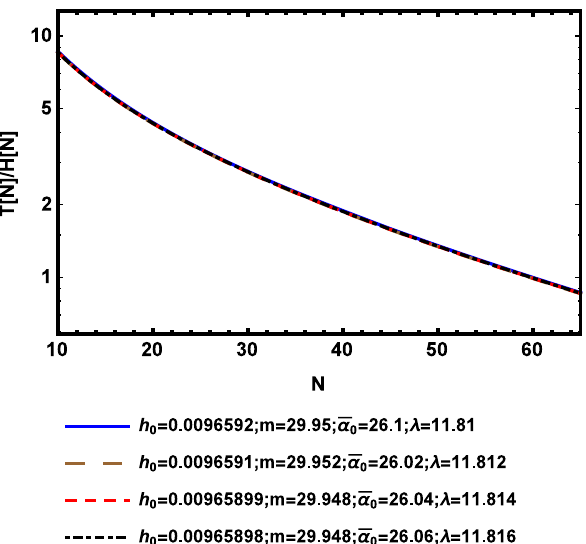
bluecontours.Intherightpanel,theresultsofPlanck2018areindicated by dark and light blue colors, referring to 68% and 95% confidence lev- els,respectively.Inbothfiguresthethickblacklinesgivethepredictions of the non-comoving warm inflation model, while the small, brown, and large,green,circlesarethevaluesof n s atthenumberofe-folds N = 58 and N = 62, respectively